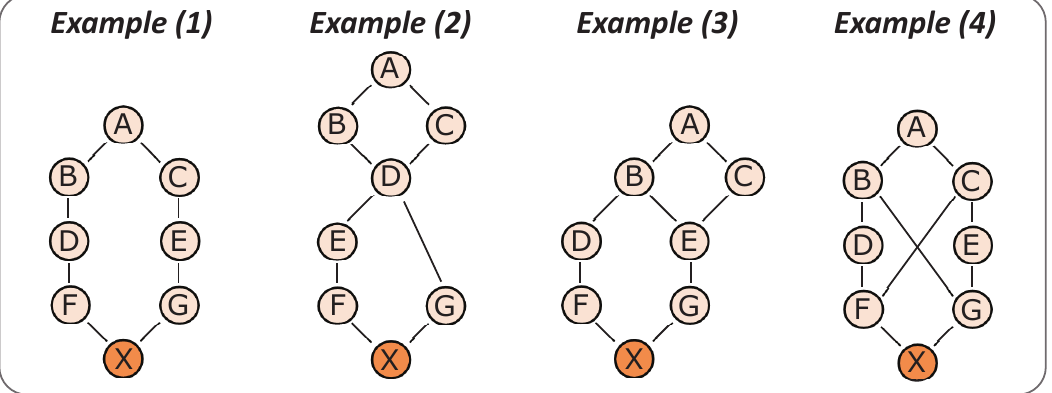
Figure 1. Example pedigrees for the calculation of classical and Kalinowski’s inbreeding coe ffi cients. X is the individual of interest and the other letters represent ancestors of X. Inbreeding coe ffi cients for individual X, corresponding to the four pedigrees, are shown in Table 1. Table 1. Inbreeding coefficients for four example pedigrees (Figure 1), estimated with revised and previous version of GRain.